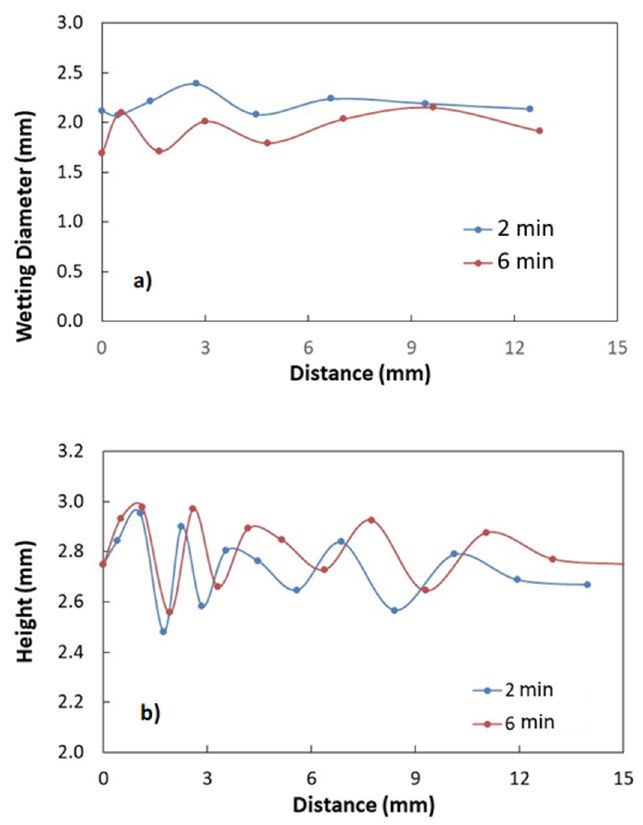
Figure 5. Water droplet translational velocity along 2 and 6 min treated surfaces. Droplet volume is 30 µL and inclination angle ( δ ) of treated surface is 10°.